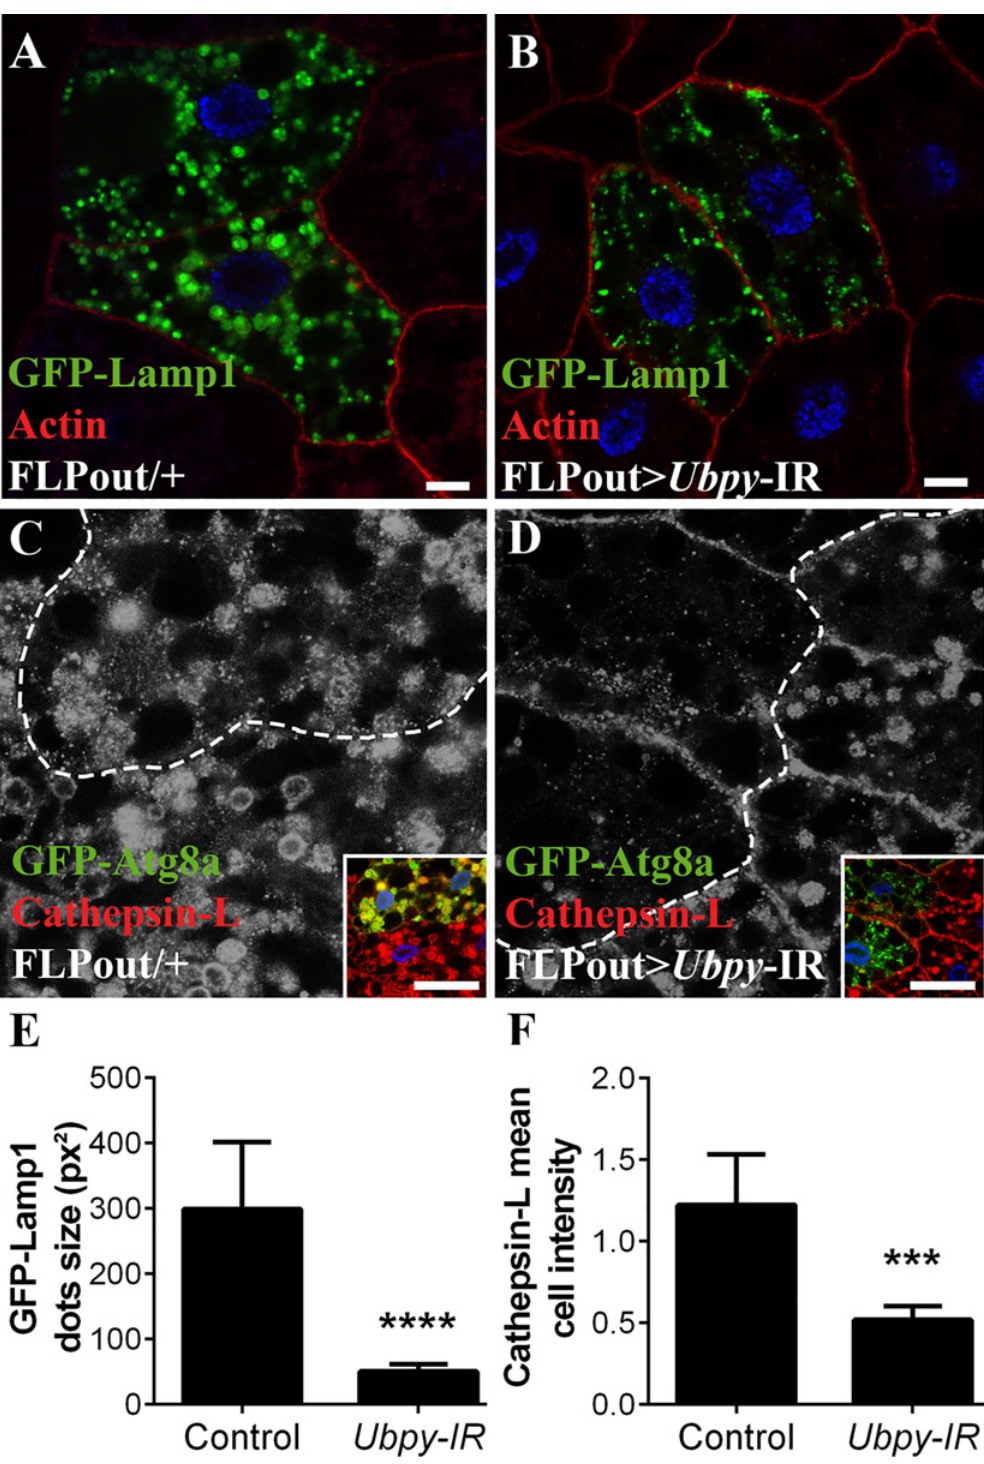
Fig 5. Ubpy silencing induces lysomal defects. (A,B) Confocal sections of larval fat bodies clonally expressing the lysosomal markers GFP-Lamp1 alone (A) or in combination with the Ubpy silencing transgene (B). (C,D) Confocal sections of larval fat bodies clonally expressing the autophagy reporter GFP-Atg8a alone (C) or in combination with the Ubpy silencing transgene (D) after staining for the endogenous lysosomal hydrolase Cathepsin-L. Insets show the merged channels of the respective images and the clone boundaries are indicated as dotted lines (E). Quantification of GFP-Lamp1 dots size. (F) Quantification of the mean relative intensity of the Cathepsin-L staining in GFP-Atg8a expressing cells compared to the staining intensity of the adjacent wild-type neighboring cells.